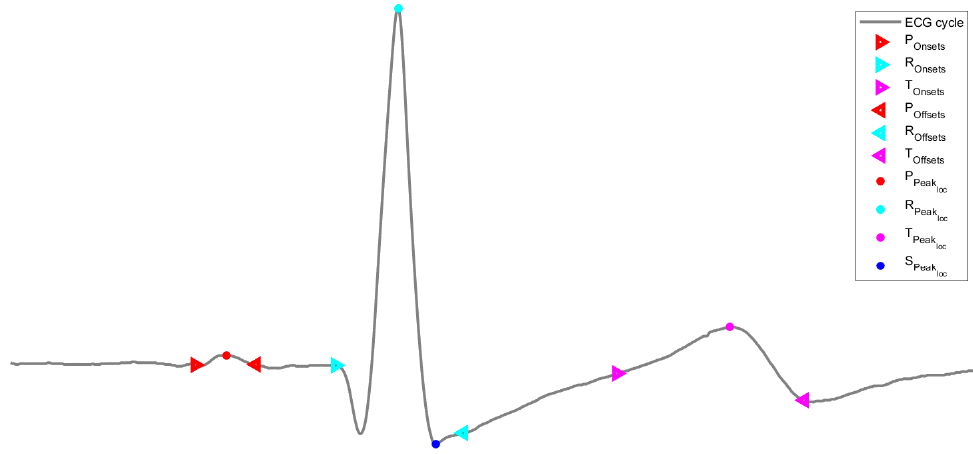
Figure 5. Location of the extracted peaks, onsets, and offsets of an ECG